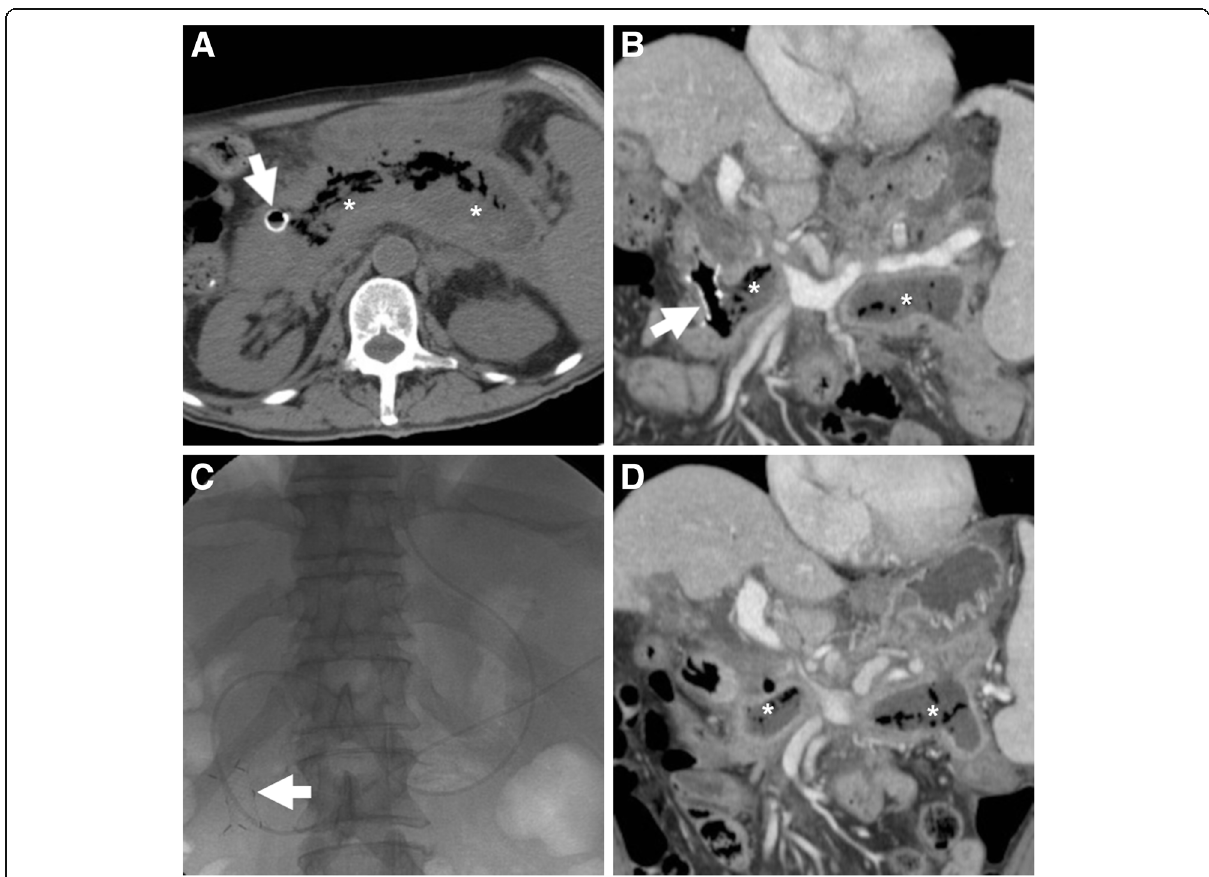
Fig. 7 Post-procedural unenhanced ( a ) and post-contrast ( b ) MDCT in an elderly 81-year-old male following trans-duodenal endoscopic cystostomy (ECS) showed communication between duodenum and WOPN (*) via a metal stent (thick arrows), and development of air within the treated collection. Necrosectomy was then performed via nasobiliary drain through the stent (thick arrow in c ). Follow-up MDCT ( d ) showed loss of the stent and partial decrease of the WOPN (*)